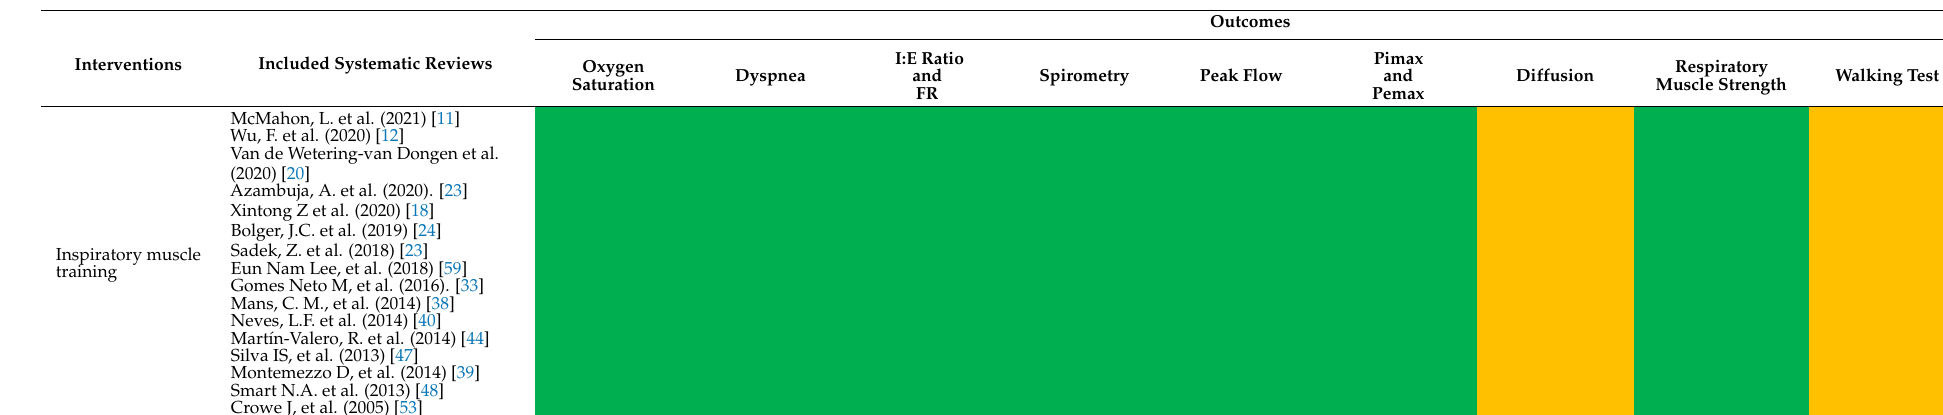
Table 4. Summary of